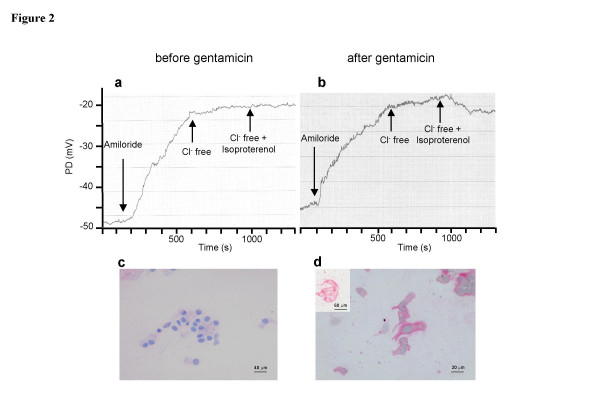
Example of nasal potential difference tracing (NPD) (a, b) and CFTR immunostaining with MATG 1061 monoclonal antibody of nasal ciliated cells (c,d) before (a,c) and after (b,d) parenteral gentamicin treatment in a Y122X homozygous CF patient. In (d), insert of nasal epithelial cells from a healthy control subject. Scale bars are 40, 20 and 60 microns for (c), (d) and insert, respectively. (a) NPD before treatment showed a basal NPD of -50 mV, strong depolarisation in response to 100 μM amiloride (25 mV), and no significant response to CFTR activation by 10 μM isoproterenol in chloride-free solution. (b) At the end of treatment, basal PD was close to -45 mV, amiloride-induced depolarisation had not changed, and addition of isoproterenol in chloride-free solution induced hyperpolarisation of ~ -5 mV, indicating a CFTR-dependent chloride transport. (c) No CFTR labeling was observed before treatment. (d) After gentamicin treatment, CFTR labeling was detected in the patient's nasal cells.